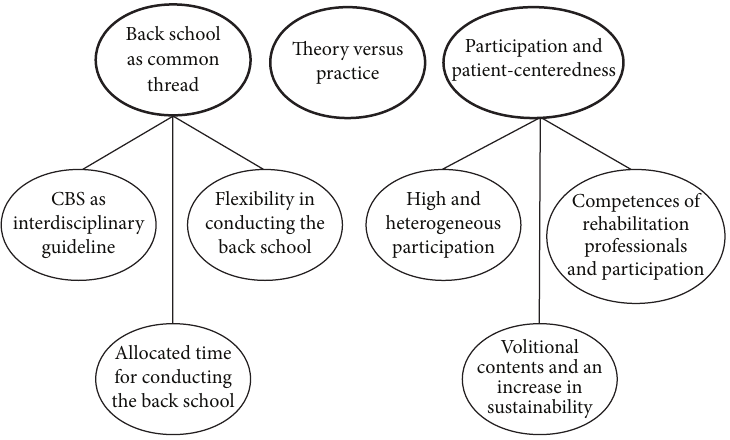
Figure 2: Central themes derived from the